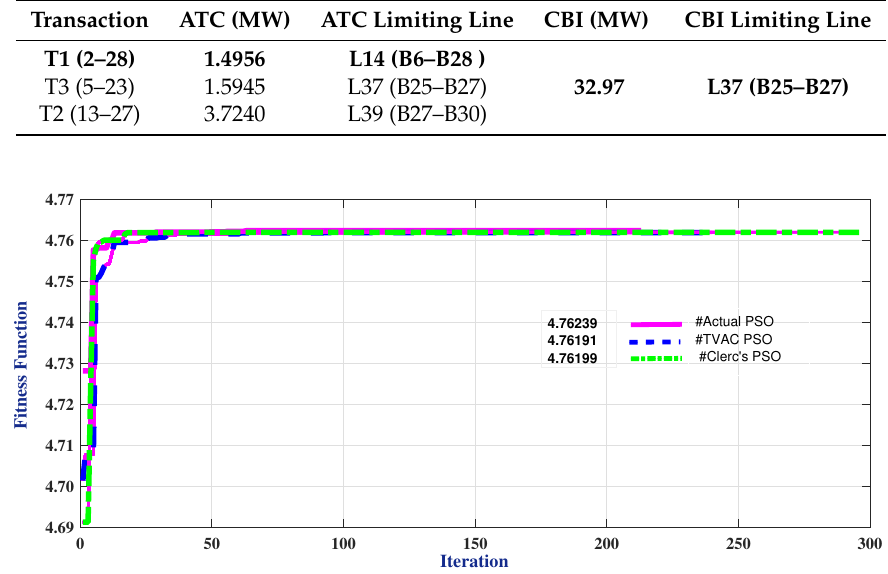
Figure 4. IEEE 30-Single line diagram and investigated inter-zone transactions [23]. Table 2. Considered inter-zone bilateral transactions.